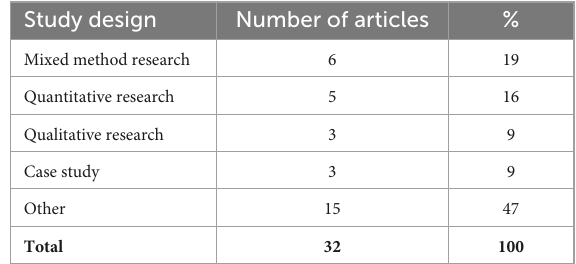
TABLE 4 Distribution by study